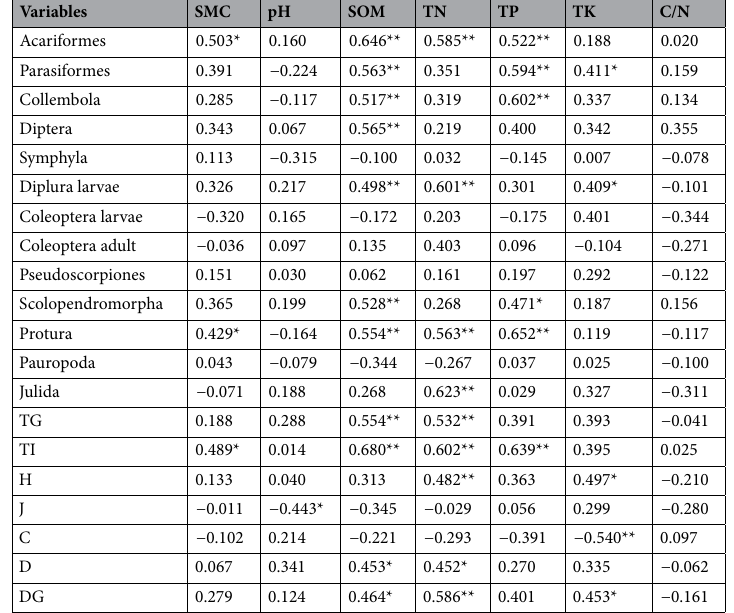
Table 5. Person correlation coefficients between soil fauna and soil properties. * P < 0.05; ** P <